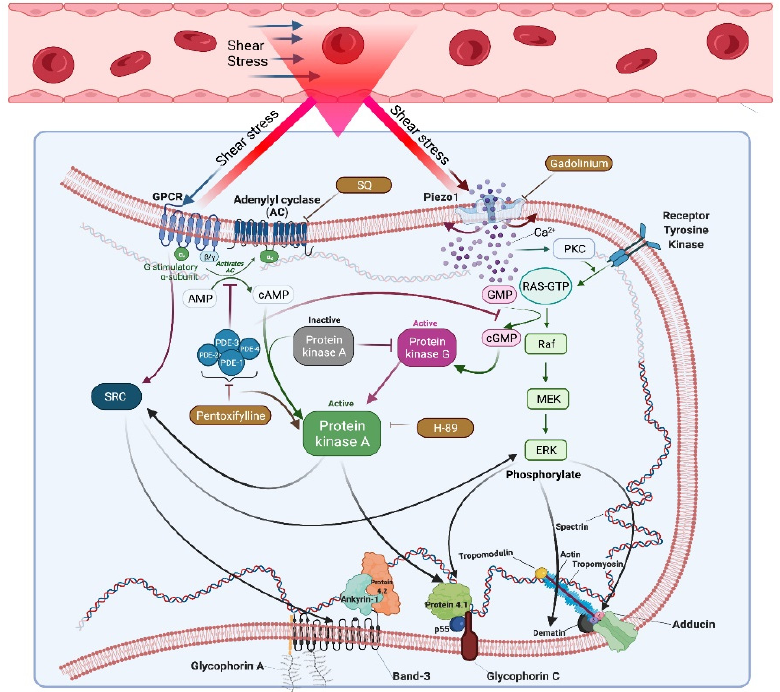
Figure 6. A schematic illustration for the phosphorylation events through cAMP signaling mechanisms. Shear stress in blood flow could be sensed via Piezo1 and GPCRs that trigger cAMP signaling or crosstalk between signaling pathways. Closed lines show an inhibition and black arrows represent a phosphorylation event. GPCR: G protein-coupled receptors, PDE: Phosphodiesterase, PKC: Protein kinase C.